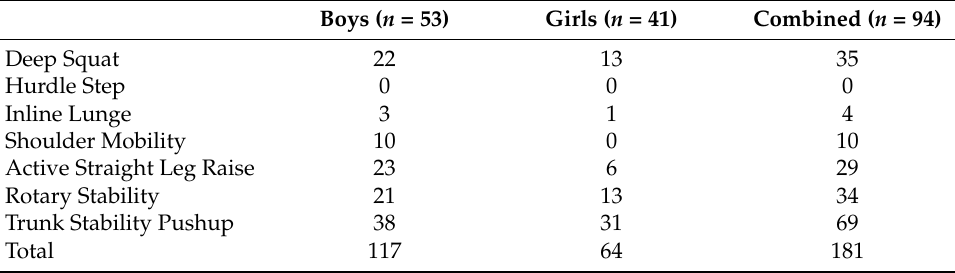
Table 4. Distribution of dysfunctional scores for each test.